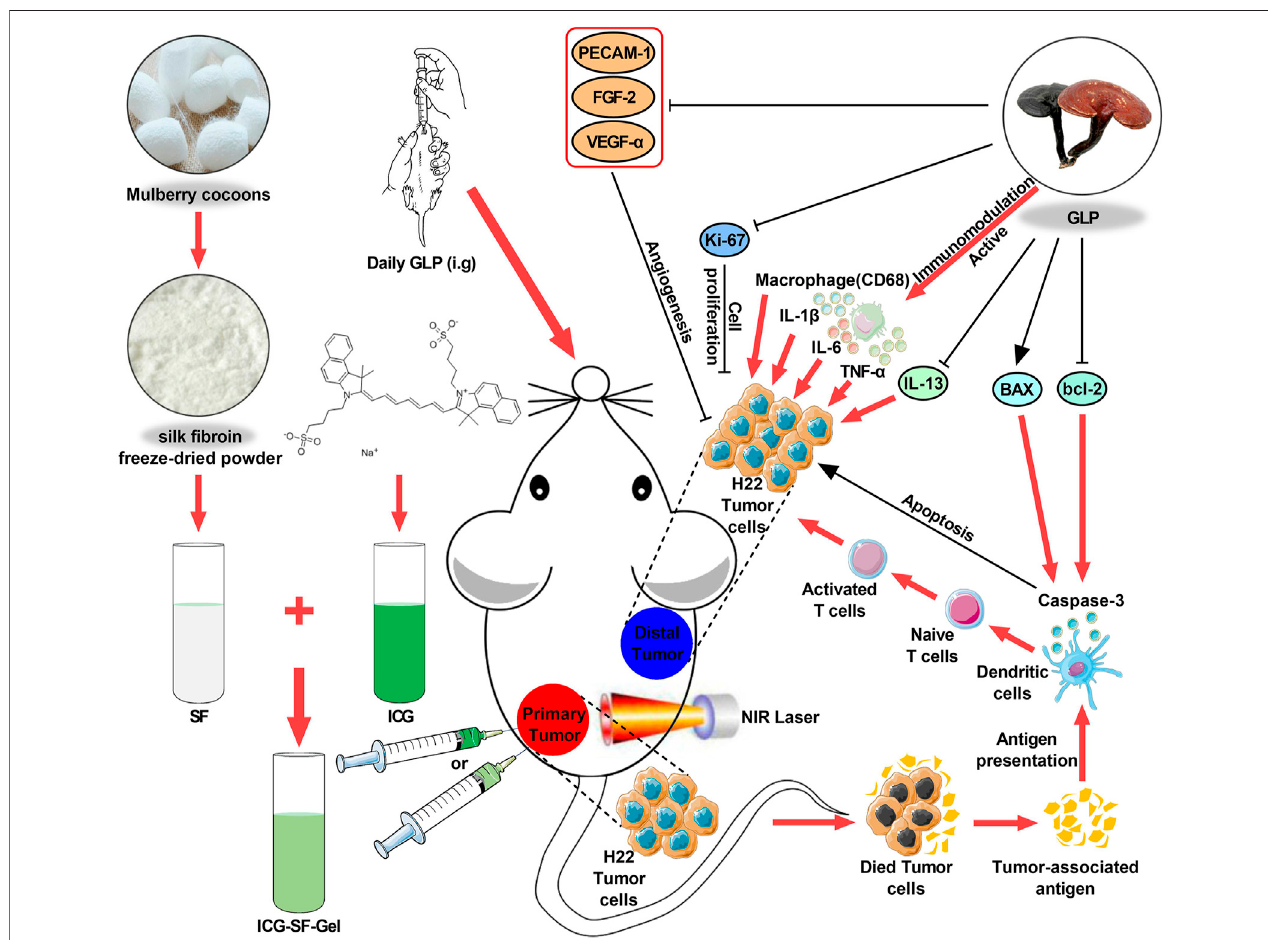
FIGURE 1 | Schematic design of ICG/ICG-SF-Gel and the distal antitumor mechanism of ICG/ICG-SF-Gel-based photothermal therapy and GLP immunotherapy in hepatoma-bearing mice.; Abbreviations: SF, Silk fi broin;GLP, Ganodermalucidum polysaccharides; ICG, Indocycline green; ICG-SF-Gel, Indocyaninegreen and Silk fi broin Gel; NIR,